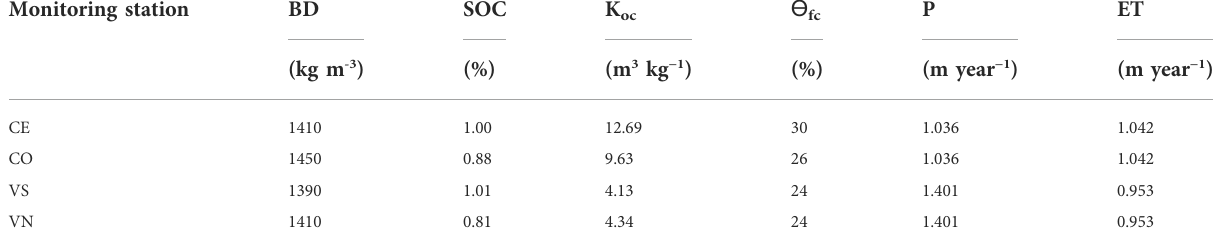
TABLE 3 Values and parameters are used to calculate AF. BD is bulk density, SOC is soil organic carbon, K oc is the repartition coef fi cient between waterandorganiccarbon, Ɵ fc isthewatercontentat fi eldcapacity,Pisannualprecipitation,andETisannualevapotranspirationcalculatedfrom data recorded by the weather station from October 2018 to September